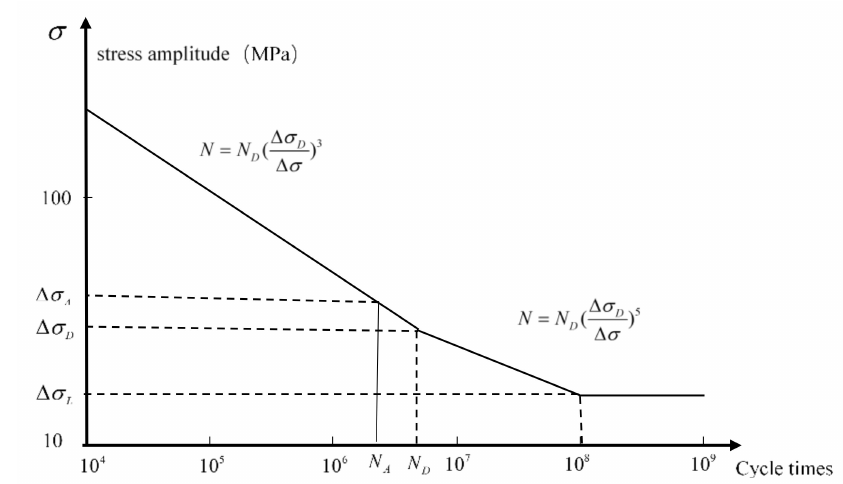
Figure 12. S–N curve for a high-strength